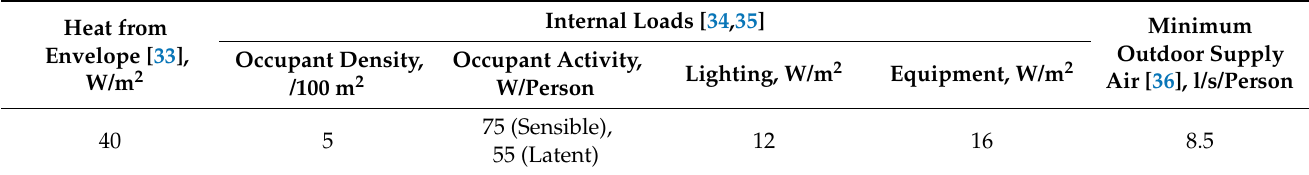
Table 1. Heat loads and fresh air rate for the test room